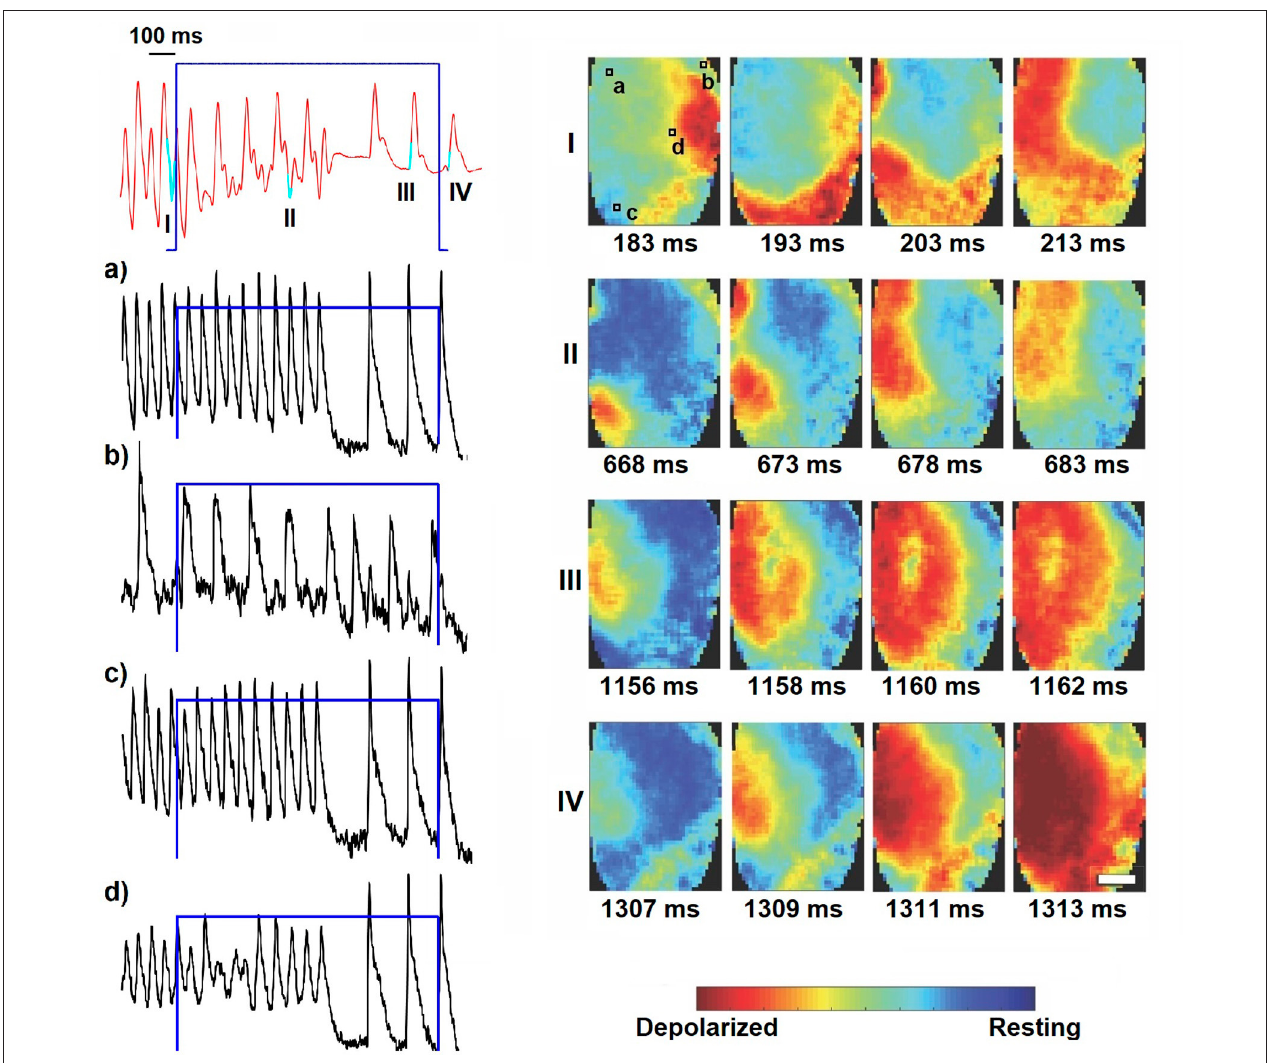
FIGURE 6 | Optical determination of the second identified mechanism, which was only observed in 1s pulses (0.25mWmm − 2 , highlighted in blue). Here the locally stable spiral activity (image sequence I) is disrupted by the illumination resulting in extrusion of the arrhythmic wave pattern to the boundaries (image sequence II). Already during photostimulation the sinus rhythm resets (image sequence III) and continues after switching off (image sequence IV). The scale-bars indicate 2mm and are equal for all images in the corresponding panel. Shown are the MAP recording (in red) and optical traces of several local spots on the ventricles (in black, as indicated in panel I). The corresponding movie is available as ( Supplementary Material Movie 3